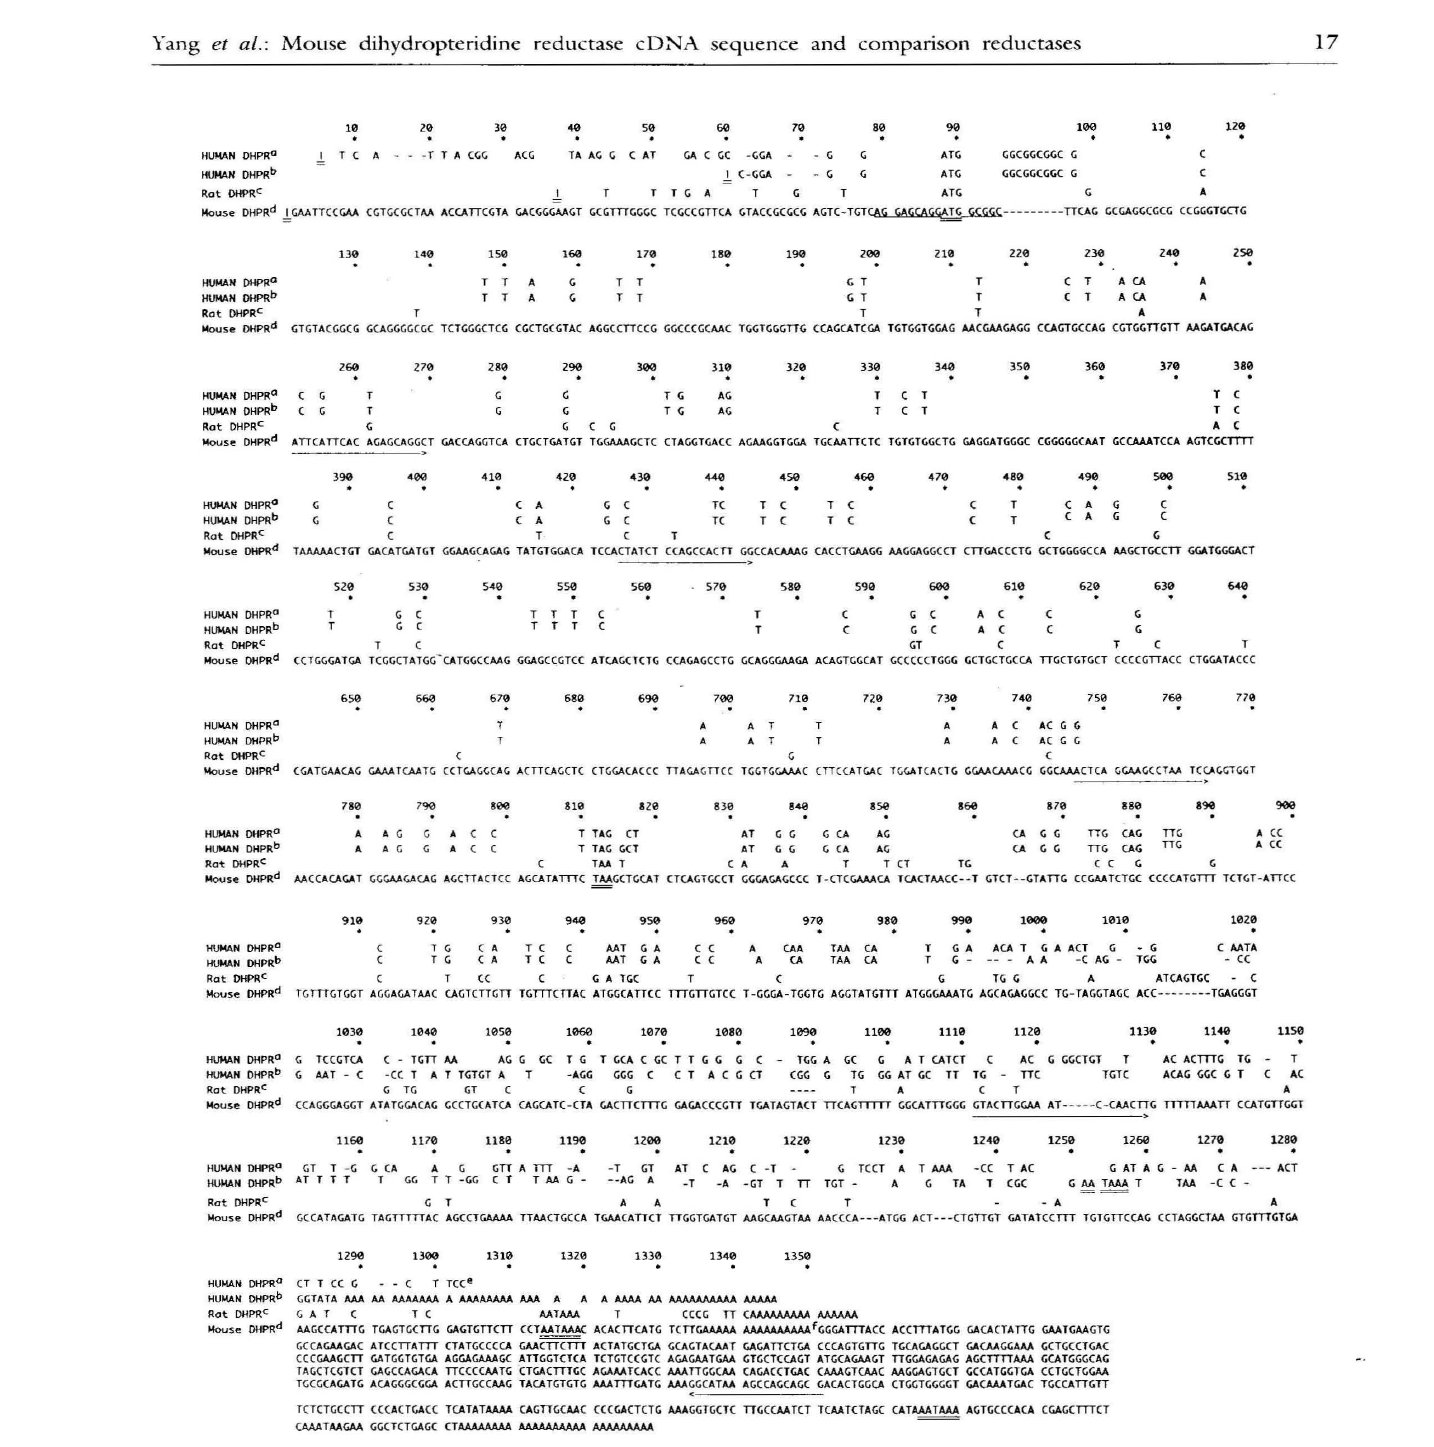
Figure 2. cDNA sequences of human C from ref 6 and h from ref 5), rat (' from ref 7) and mouse (d clune 1) dihy dropteridine reductase. The sequences start l. Empty gaps mean that the sequuence is identical with the mouse sequence, except where the identity needs to be stressed, e.g. the ATG codon. Consensus sequences are double underlined. "Continues: TGTGTGGTTG CCCCTGTGCC TGTGGTC'TGG CCTAGGTTAA GTGTGCAAGA TAACTACrCG TGAGTrKI'TC AGAATGTTG TTCCTAATAA ATGCATTGT TGTCTGTCTT CTITAATCAA ATCACATCTr ATATACAGCA GTCAGAGATG AGTATACTAG AATCATGGAT TGCTGGAGGT CTTT1' AATCT GATGTTCTCA GAAGGGGGTG GA lTf AAA TC CTGAAATAAA TA TITCAACA CAAAAAAAAA AAAAAAAA lEnd of mouse clone 2. Position and direction of sequencing primers is indicated by arrows below the